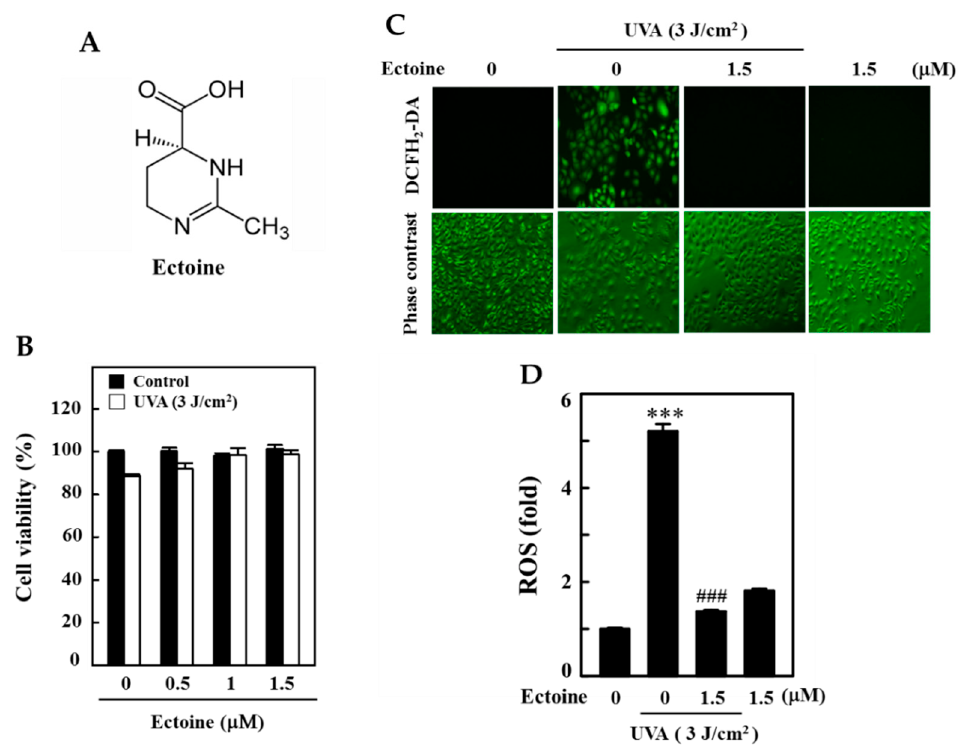
Figure 1. Ectoine inhibits UVA-induced ROS production in human keratinocyte (HaCaT) cells. ( A ) Ectoine’s chemical structure. ( B ) To determine cell viability, an MTT assay was used. Cells were treated with Ectoine (0.5, 1, and 1.5 µ M) for 24 h. Then, they were irradiated with 3 J / cm 2 or without UVA. ( C , D ) Cells were pre-treated with Ectoine (0 or 1.5 µ M) for 24 h and then irradiated with 3 J / cm 2 or without UVA. For each condition, we used the percentage of the fluorescence intensity of the DCF-stained cells as determined by Olympus Softimage. Statistical significance was assigned as *** p < 0.001 compared to the untreated control cells and ### p < 0.001 compared to the UVA-exposed HaCaT